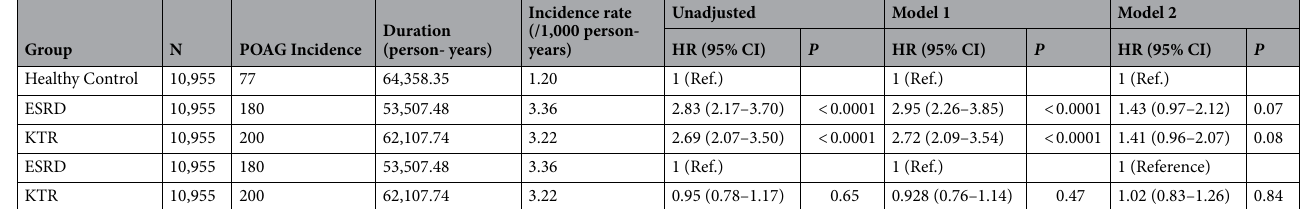
Table 2. POAG incidence in ESRD patients, KTRs, and healthy controls. Model 1: Cox proportional hazard (PH) regression model adjusted for age and sex. Model 2: Cox proportional hazard (PH) regression model adjusted for age, sex, diabetes mellitus, hypertension, dyslipidemia, income, and Charlson comorbidity index. POAG primary open-angle glaucoma, HR hazard ratio, CI confidence interval, ESRD end stage renal disease, KTR kidney transplantation